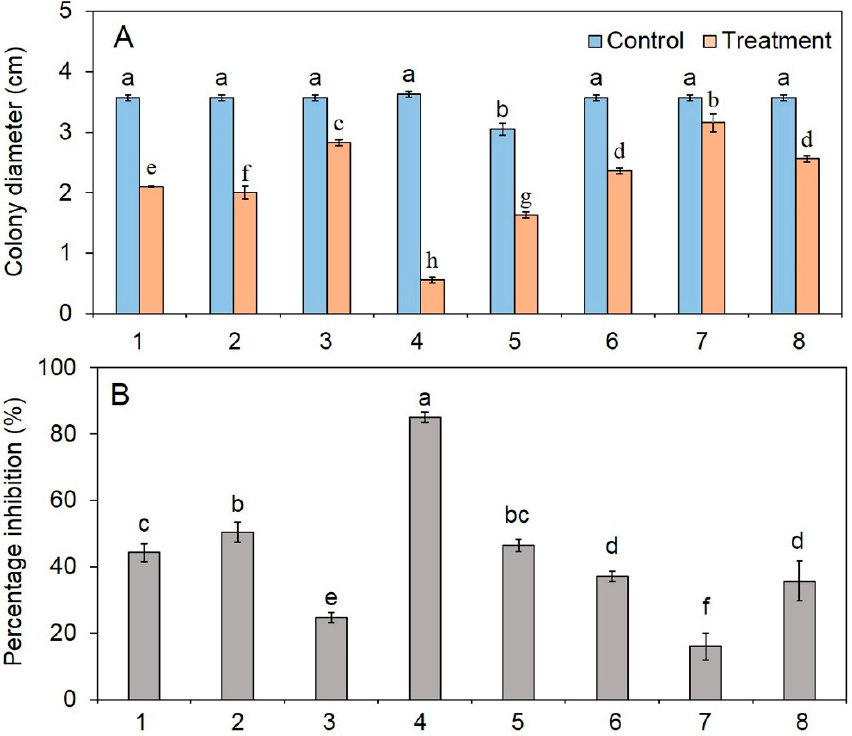
Figure 2. Colony diameter ( A ) and percent inhibition ( B ) by the VOCs emitted from T. asperelloides PSU-P1 against Colletotrichum sp. (1), C. cassiicola (2), C. lunata (3), Ganoderma sp. (4), P. oxalicum (5), N. clavispora (6), S. rolfsii (7), and S. cucurbitacearum (8). Different letters indicate statistically significant